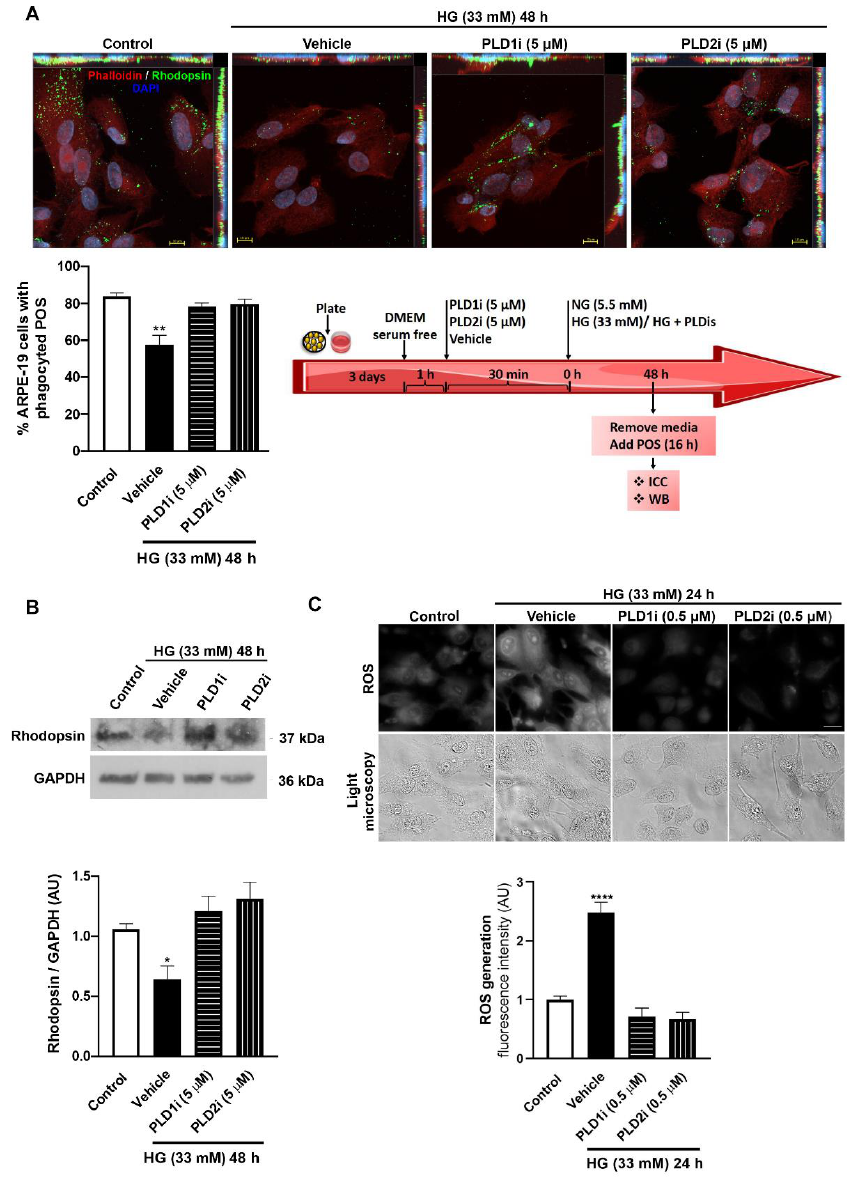
Figure 2. Effect of PLD1i and PLD2i on photoreceptor outer segments (POS) phagocytosis by ARPE- 19 cells exposed to HG. For A and B, ARPE-19 cells were seeded onto coverslips and pre-incubated with vehicle (0.025% DMSO), PLD1i (5 µ M), or PLD2i (5 µ M) for 30 min, then exposed to control condition (NG plus vehicle, 0.025% DMSO), HG (33 mM) plus vehicle, HG plus PLD1i (5 µ M), or HG plus PLD2i (5 µ M) for 48 h. Then, medium was removed and cells were incubated with unlabeled POS suspension in DMEM at a 1:10 (cell:POS) ratio for 16 h and internalized POS were detected by immunocytochemistry assays as described in the Materials and Methods section. ( A ) Representative confocal microscopy images (z-stacks maximum intensity projection) show rhodopsin staining (green), DAPI (blue) and phalloidin staining (red). Orthogonal view from different planes (x/y, x/z or y/z) of the confocal microscope images are shown (Scale bar = 10 µ m). Bar graph shows the % of ARPE-19 cells with internalized POS. Asterisks (*) indicate significant differences with respect to control condition (** p < 0.01). ( B ) Internalized POS were measured by WB to detect rhodopsin and GAPDH. Molec- ular weights are indicated with numbers to the right. Bar graph shows the densitometry values of rhodopsin/GAPDH expressed as arbitrary units (AU) with respect to control conditions (NG). Signifi- cant differences with respect to NG are indicated with asterisks (* p < 0.05). The whole